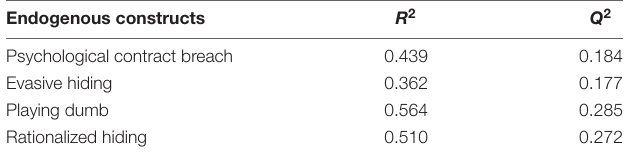
TABLE 3 | Coefficient of determination and predictive